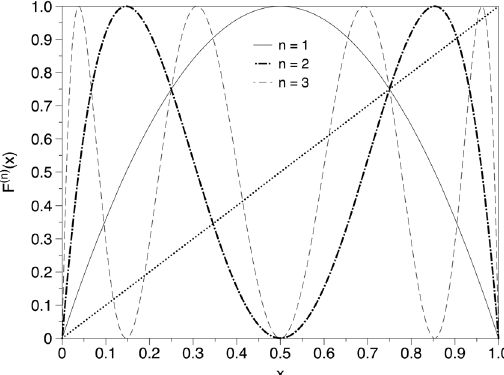
Figure 10. A few iterations of the fully chaotic logistic map x ( t + 1) = F ( x ( t )); F ( x ) = 4 x (1 − x